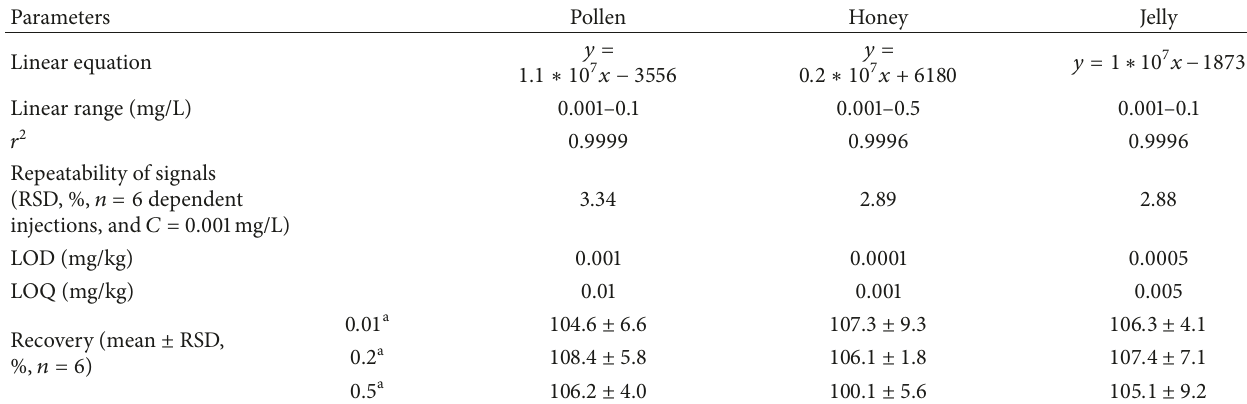
Table 4: Partial validation parameters of triadimenol added in different blank